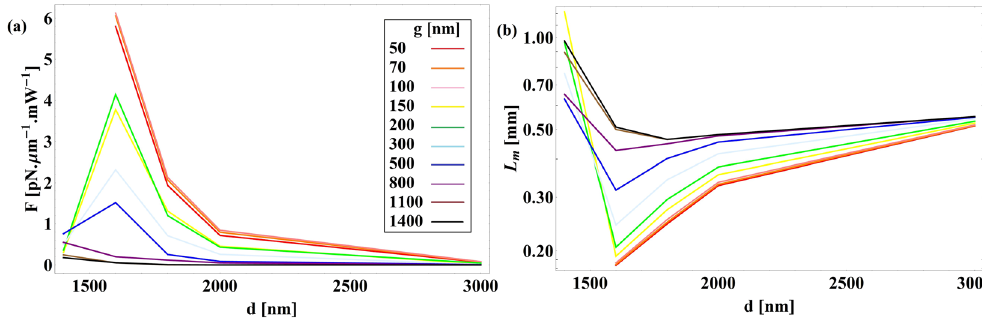
Figure 11. ( a ) Optical force versus waveguide’s diameter for different gap sizes for a semi-insulating InP waveguide above the InP:Si substrate ( b ) propagation length of the guided mode at λ 0 = 6.8 µ